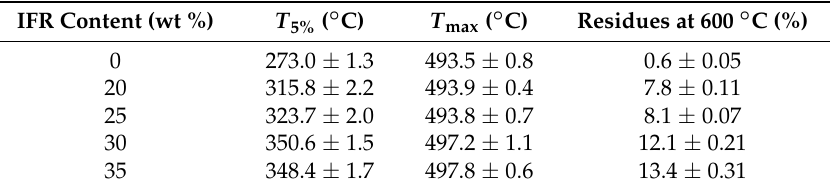
Figure 5. TGA and DTG curves of reactive extruded EPDM/PP/IFR composites with different contents of IFR (MP/PER). Table 2. TGA data of EMDP/PP/IFR with different reactive IFR contents.